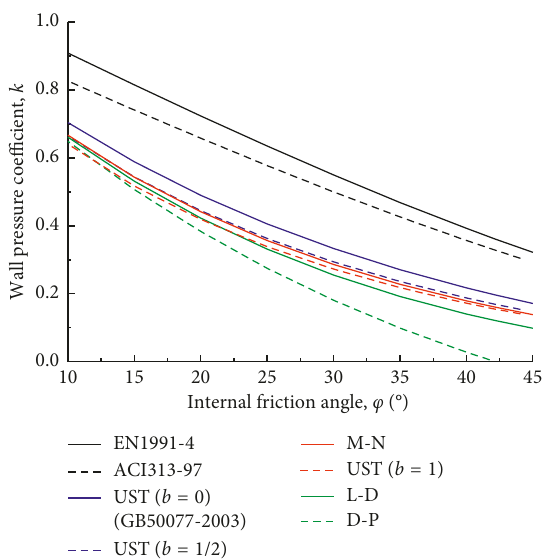
Figure 2: Comparisons of the wall pressure